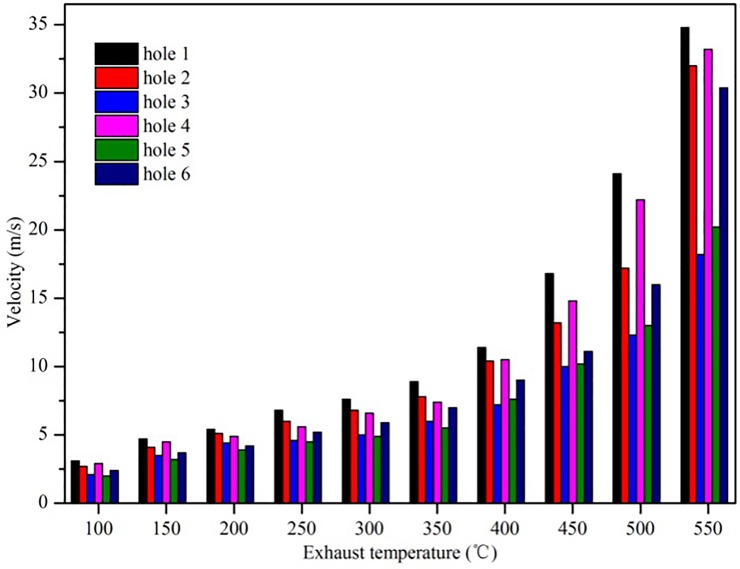
Velocity change.